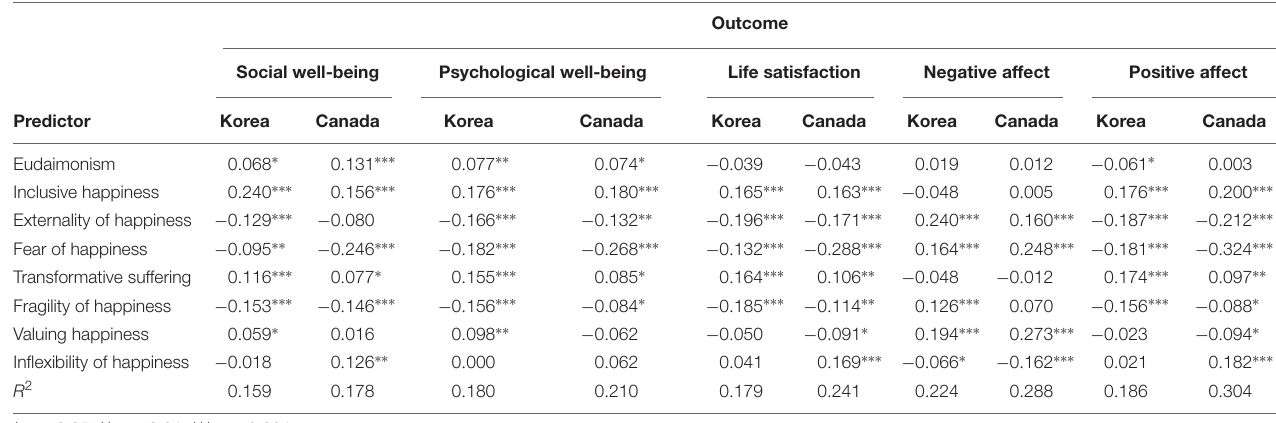
TABLE 3 | Conceptions of happiness predicting levels of well-being (standardized regression coefficients).